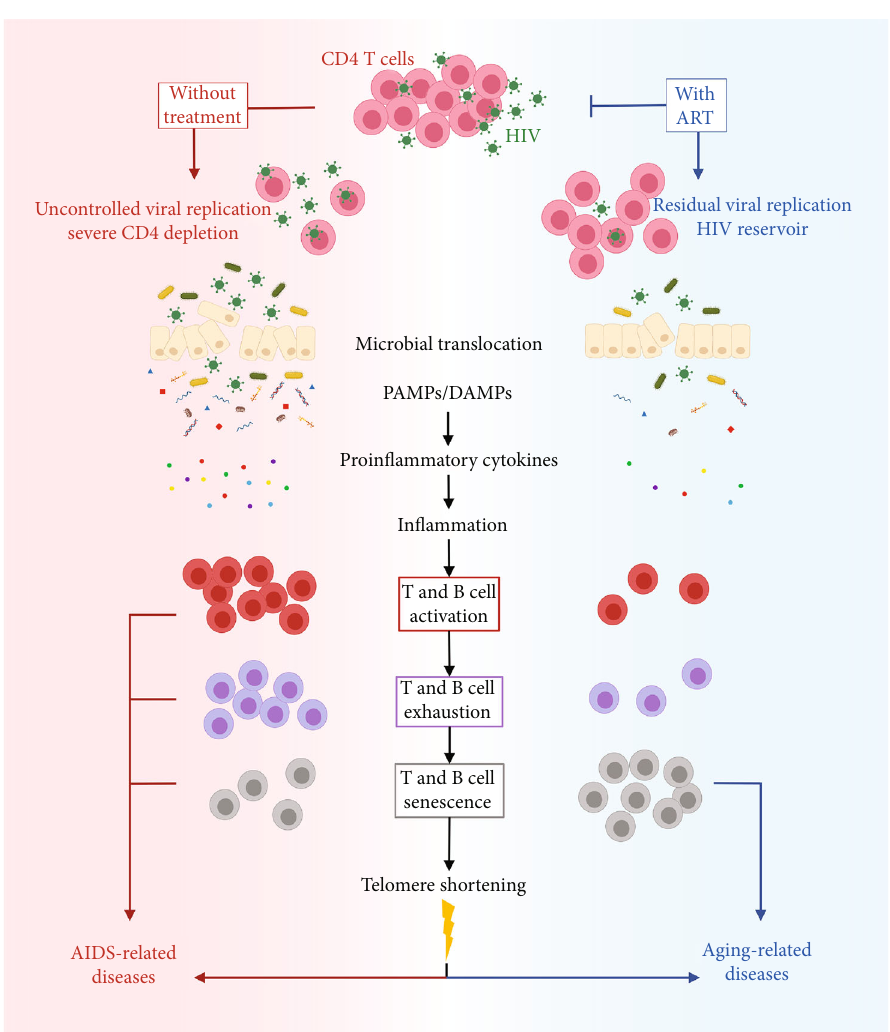
Figure 1: Schematic representation of the impact of HIV without (left side, red) and with (right side, blue) ART. HIV infects primarily CD4 cells, and without ART, there is a severe CD4 cell depletion. Microbial translocation from the damaged mucosa, releasing PAMPs (bacterial LPS, 16S rDNA, and CpG DNA) and DAMPs (mtDNA, HMGB1 protein, and defensins), stimulates the production of proin fl ammatory cytokines (IL-1, IL-6, IL-10, INF- α , and TNF- α ) that promote the activation/in fl ammatory status, a critical hallmark of HIV infection. Immunode fi ciency leads to AIDS-related diseases, including AIDS-de fi ning malignancies. With ART, a small fraction of the virus escapes control and establishes the residual reservoir, which promotes a state of chronic low-grade in fl ammation/activation, where T and B cell phenotype is altered, with increased expression of senescence markers. Accelerated telomere shortening promotes premature aging and may induce genetic instability. This scenario leads to the development of aging-related illnesses, including non-AIDS-de fi ning